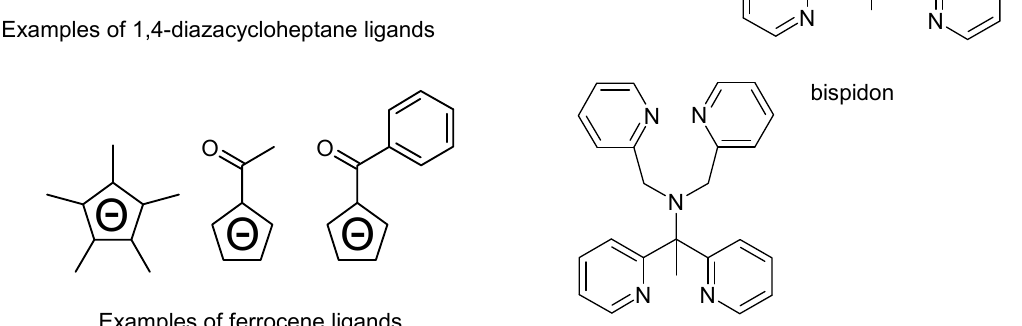
Examples of ferrocene ligands